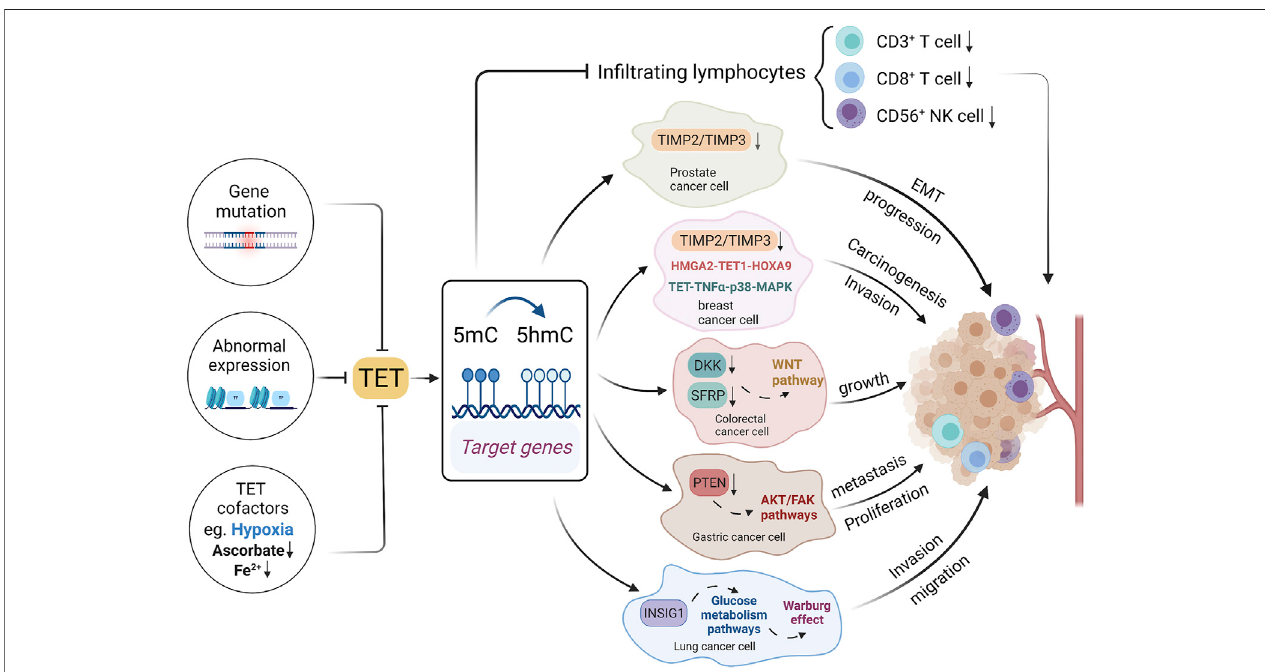
FIGURE 3 | Mechanisms underlying 5hmC and TET alterations in cancer. Gene mutations, abnormal expression and cofactors could affect TET expressions, thereby affecting DNA hydroxymethylation. The TET gene family could affect the tumor in fi ltrating lymphocyte, and it could also affect tumor development through multiple signal